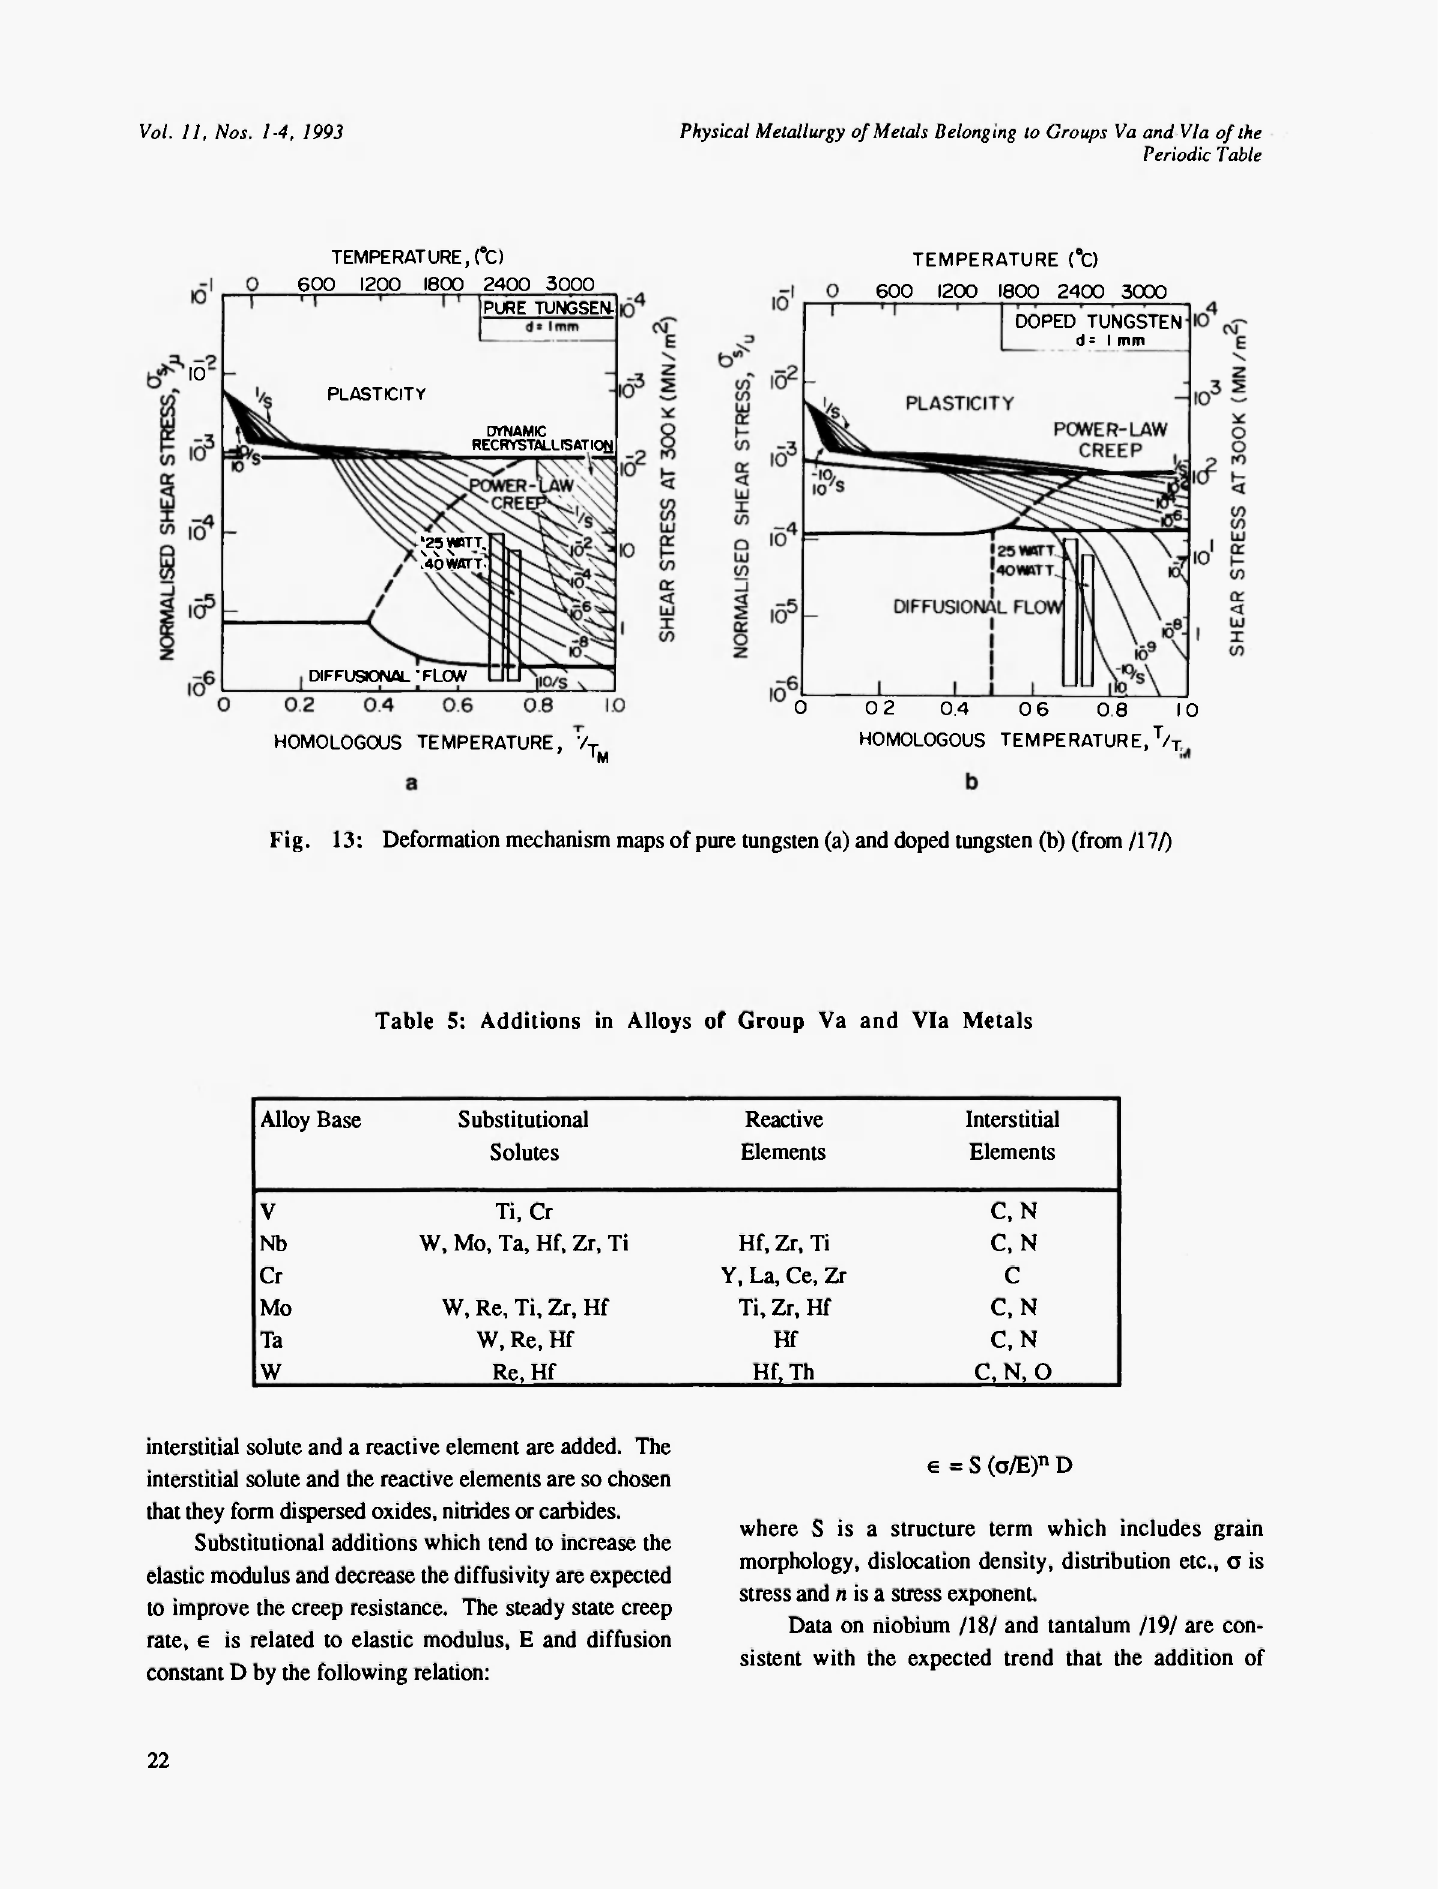
Table 5: Additions in Alloys of Group Va and Via